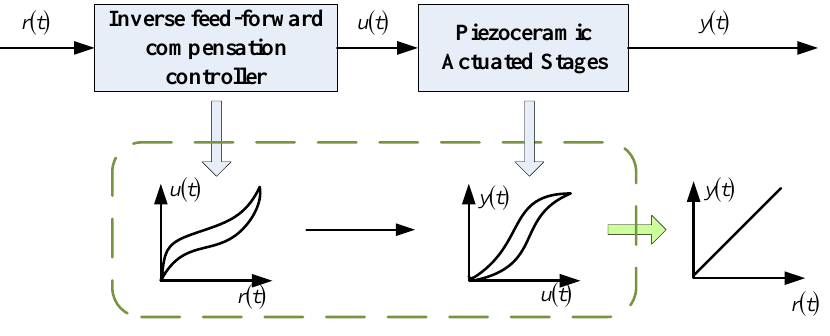
Figure 5. The principle of inverse feed-forward compensation